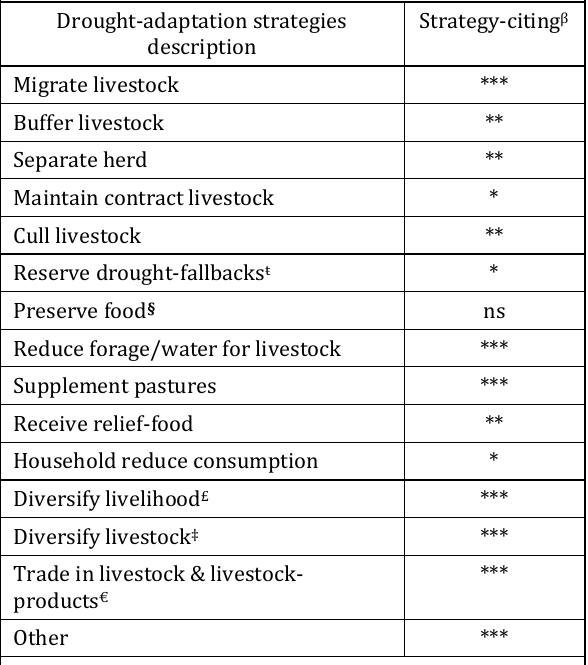
Table 1. Drought-adaptation strategies and importance estimates in the system of Maasai-pastoralism in the savanna rangelands of Kenya, ( p<0.05, N=120 ) Drought-adaptation strategies in